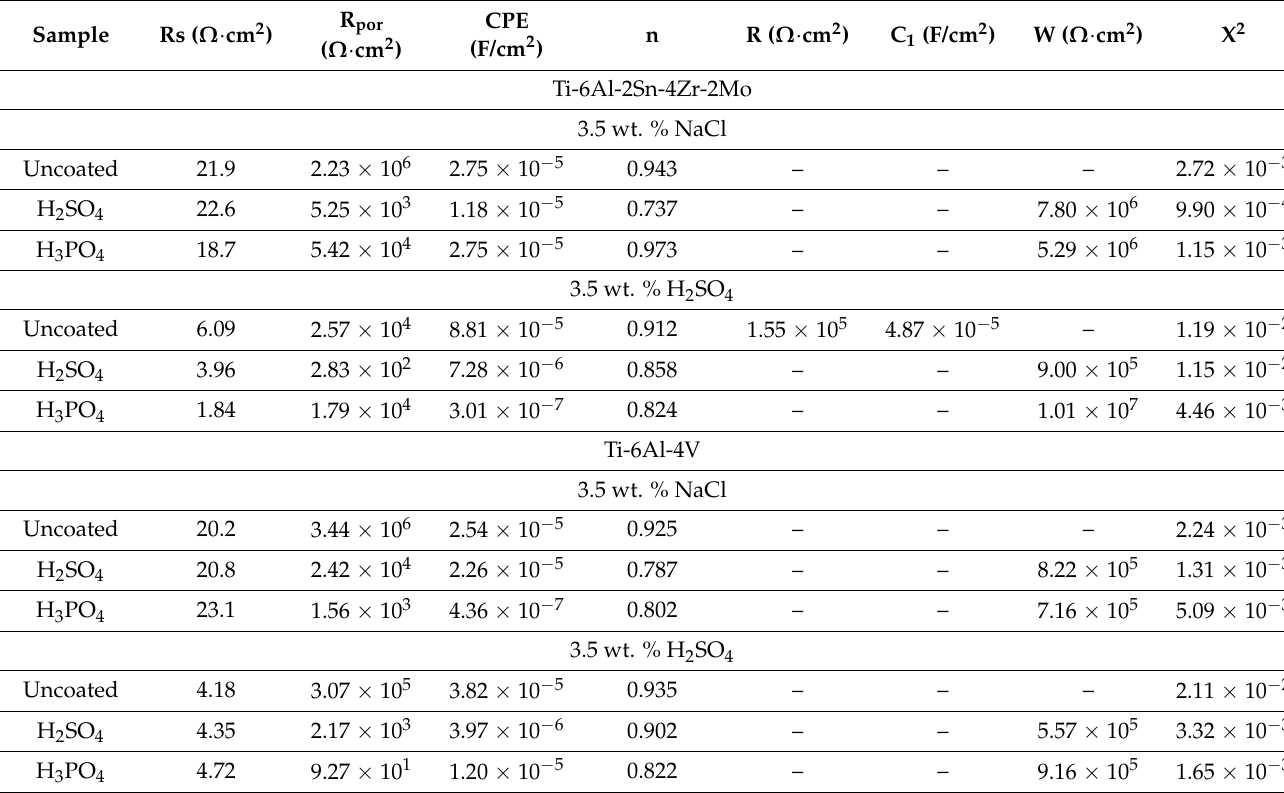
Table 3. Parameters obtained by EIS.